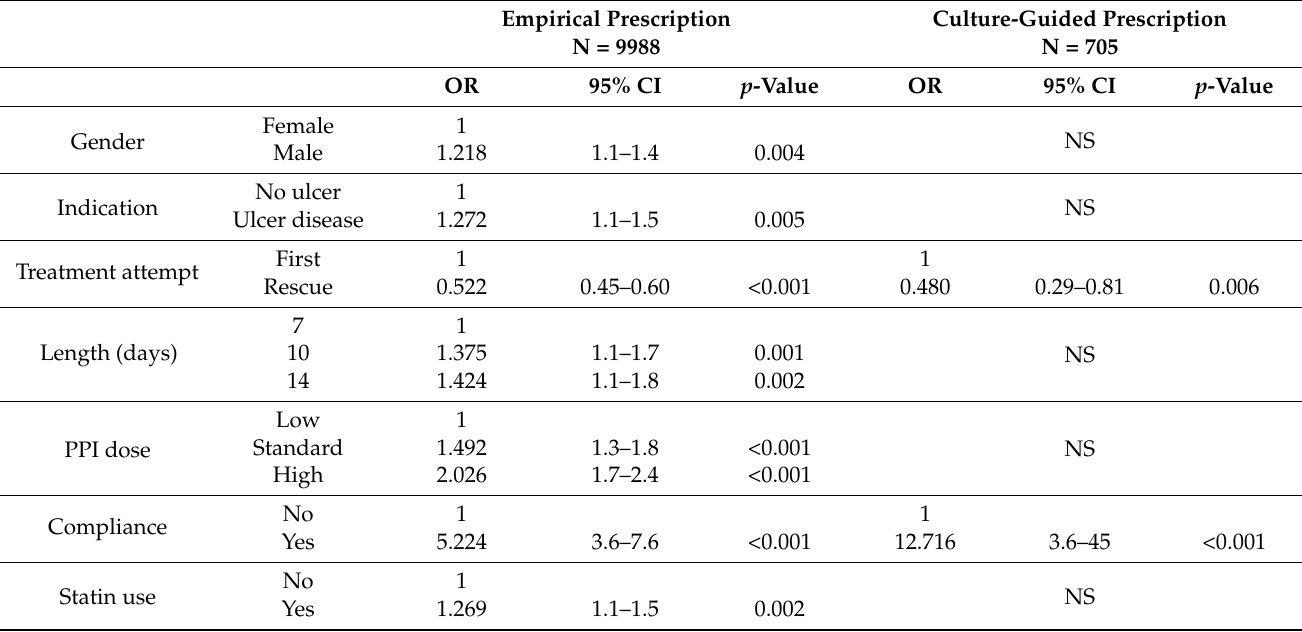
Table 4. Multivariate analysis according to mITT effectiveness in empirical versus culture-guided